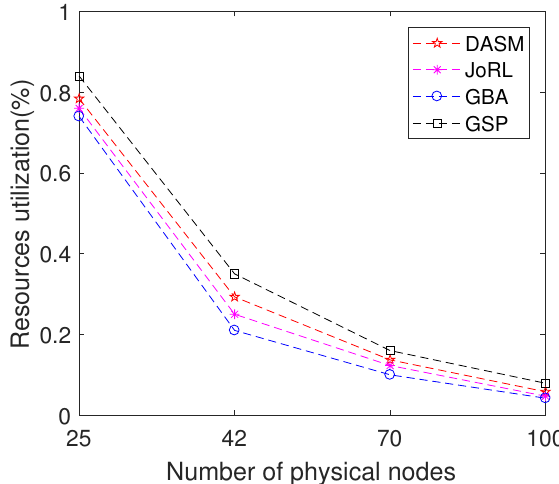
Figure 9. Resource utilization rate.